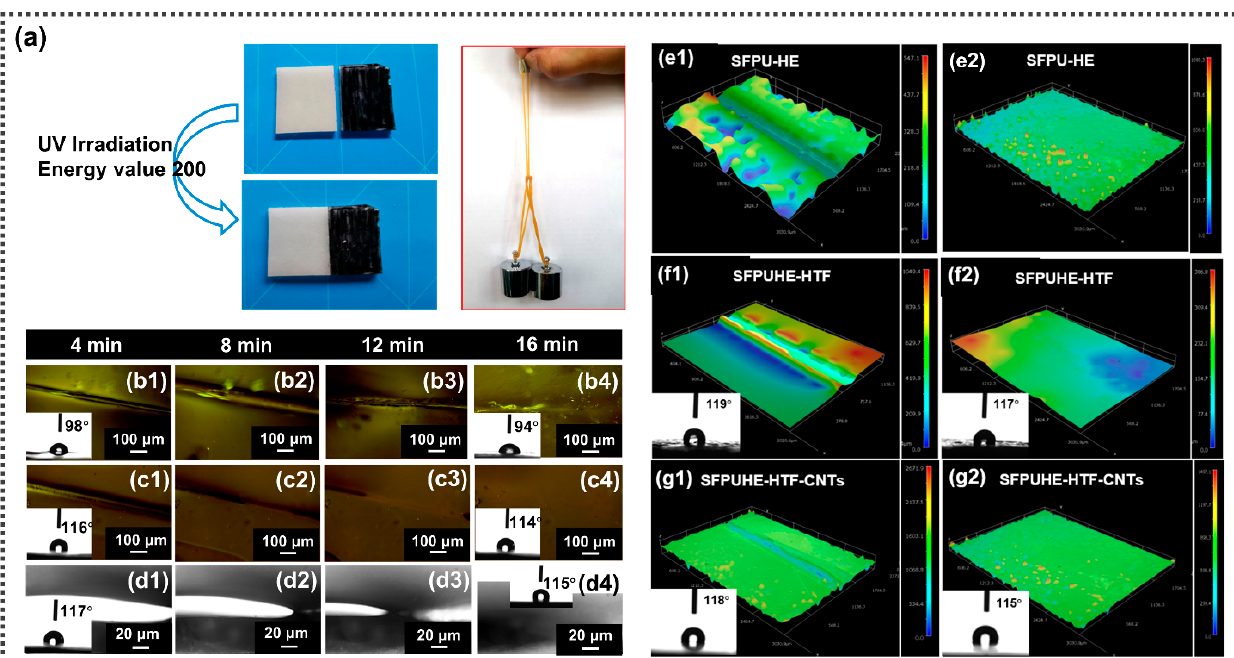
Figure 3. ( a ) Comparison of SFPUHE-HTF-CNTs before and after healing under UV light irradiation at the energy of 200; the repaired sample was not pulled off under two 100 g weights. ( b ) Images of the self-healing process of the sample taken by POM during the same time interval at 60 °C. ( b1 – b4 ) Disulfide-bonded self-healing polyurethane (SFPU-HE); ( c1 – c4 ) disulfide-bonded and fluorinated polysiloxane containing self-healing polyurethane (SFPUHE-HTF); ( d1 – d4 ) SFPUHE- HTF-CNTs; the inset diagrams show the contact angles of SFPUHE-HTF and SFPUHE-HTF-CNTs before and after repair, respectively. The 3D images (200 × ) of the surface morphology of the sample before and after repair photographed by super depth-of-field microscopy. ( e1 , e2 ) SFPU-HE; ( f1 , f2 ) SFPUHE-HTF; ( g1 , g2 ) SFPUHE-HTF-CNTs; the inset diagrams of f1, f2 and g1, g2 show the 363 contact angles of the SFPUHE-HTF and SFPUHE-HTF-CNTs before and after repair at 60 ◦